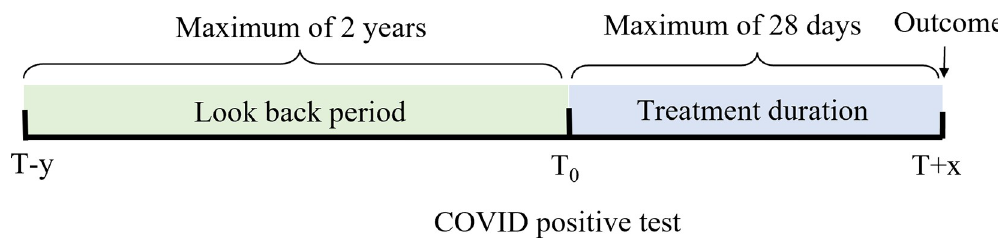
Fig 2. Time windows for treatment, comorbidities, and